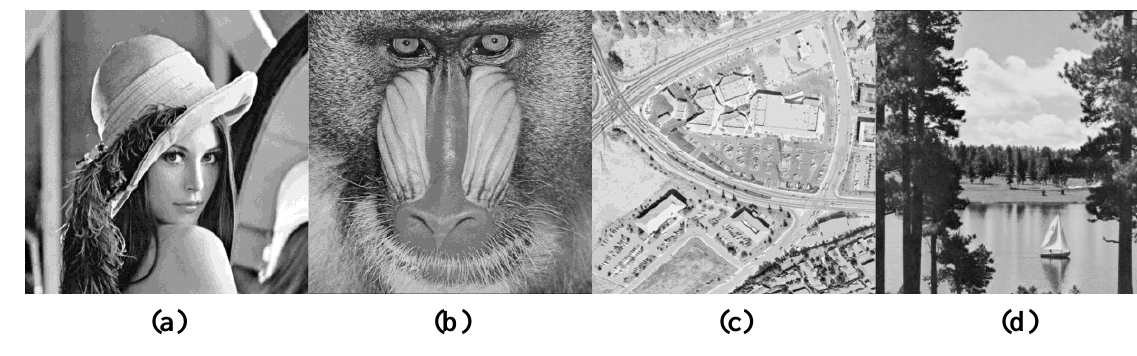
Figure 1. Grey-scaled representations [24] of ( a ) ‘Lenna’, ( b ) ‘Mandrill’, ( c ) ‘Aerial’ and ( d ) ‘Sailboat on